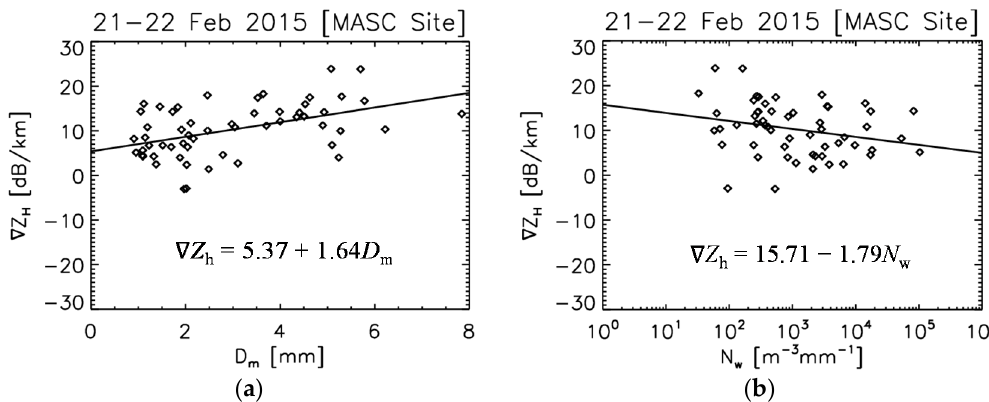
Figure 30. Scatterplots of ( a ) linked ∇ Z h versus D m and ( b ) linked ∇ Z h versus N w for the 21–22 February 2015 event. Solid lines and the corresponding linear relations ∇ Z h ( D m ) and ∇ Z h ( N w ) given in the figure represent the least-squares fitting results.